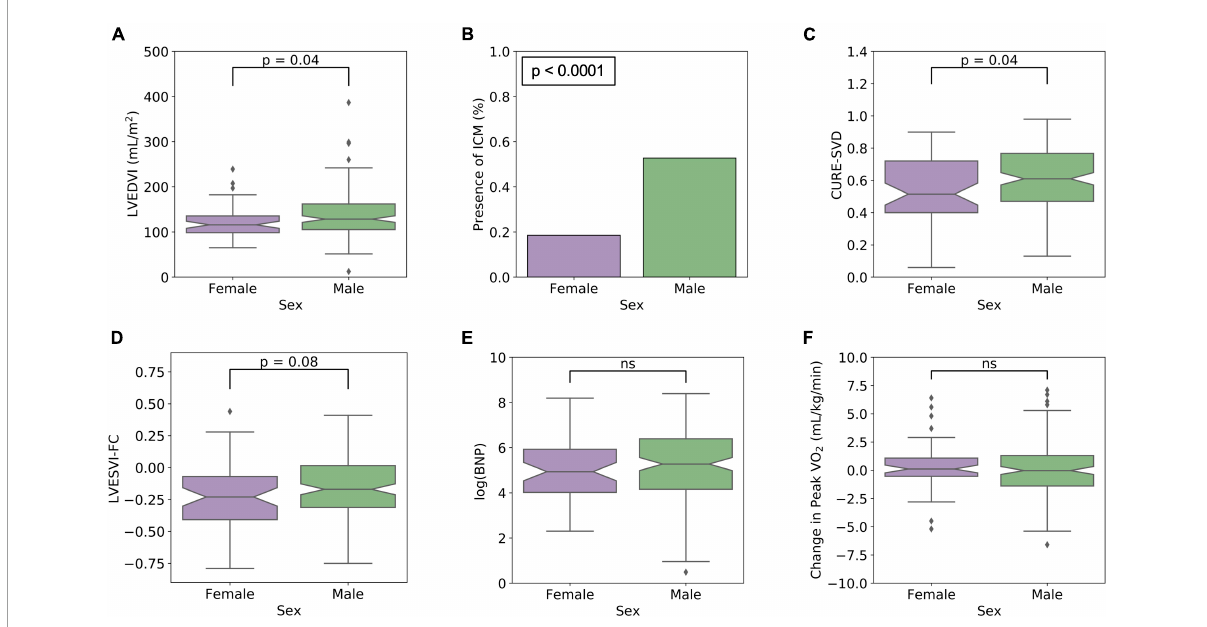
FIGURE2 Significant pre-CRT CMR findings and post-CRT response measures stratified only by sex. (A) LVEDVI ( p < 0.04), (B) ICM presence (p 0.0001), (C) CURE-SVD ( p = 0.04) are highlighted as these parameters were found to be significantly different between males and females. Compared with males, females were more likely to have smaller LVEDVI, less frequency of ICM, and lower CURE-SVD. In (D–F) , the response measures stratified by sex only (as opposed to sex and cardiomyopathy type in Figure 4 ) are shown to be similar by group.